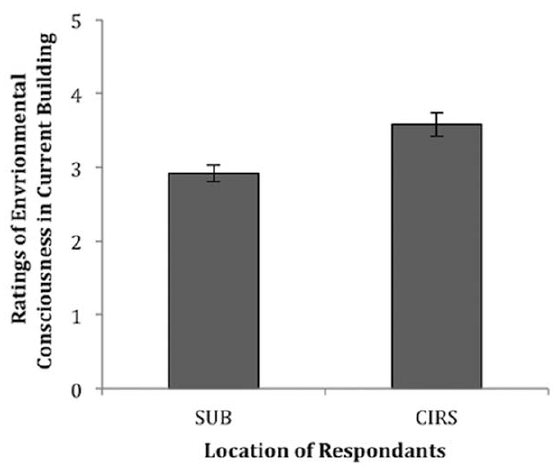
Figure 2. Self-ratings of environmental consciousness of patrons in CIRS and the SUB in their current building. Ratings range from 1 (not at all environmentally conscious) to 5 (extremely environmentally conscious). N=61, the questionnaire was administered to 31 respondents in CIRS and 30 in the SUB. Respondents in CIRS rated themselves as significantly more environmentally conscious in their current environment ( M =3.58, SD =.90) compared to respondents in the SUB ( M =2.92, SD =.60). Error bars represent standard error of means.